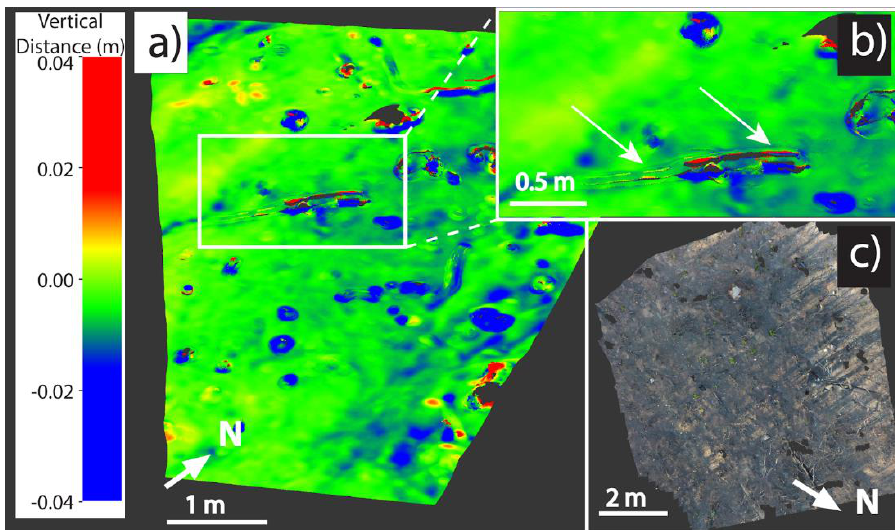
Figure 4. ( a ) Vertical distance between the October 2019 and February 2020 UAV-derived point clouds, using the M3C2 algorithm in the CloudCompare software. Two sub-parallel minor offsets are indicated by white arrows ( b ), while a fallen tree branch is visible in red colour. UAV–SfM-derived orthomosaic (map view) of the examined area ( c ).